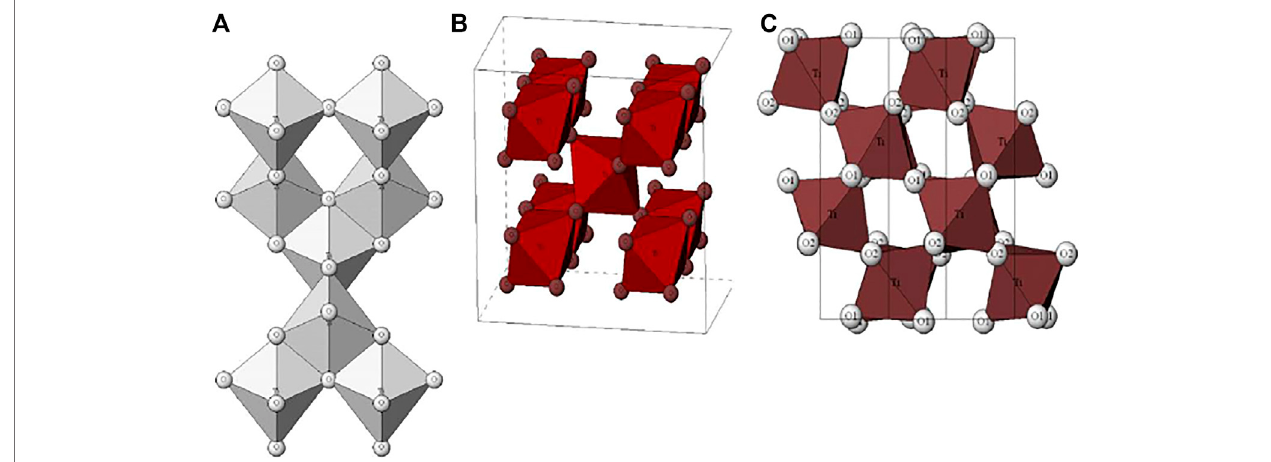
FIGURE 1 | TiO 2 crystal structure (A) anatase TiO 2 , (B) rutile TiO 2 and (C) brookite TiO 2